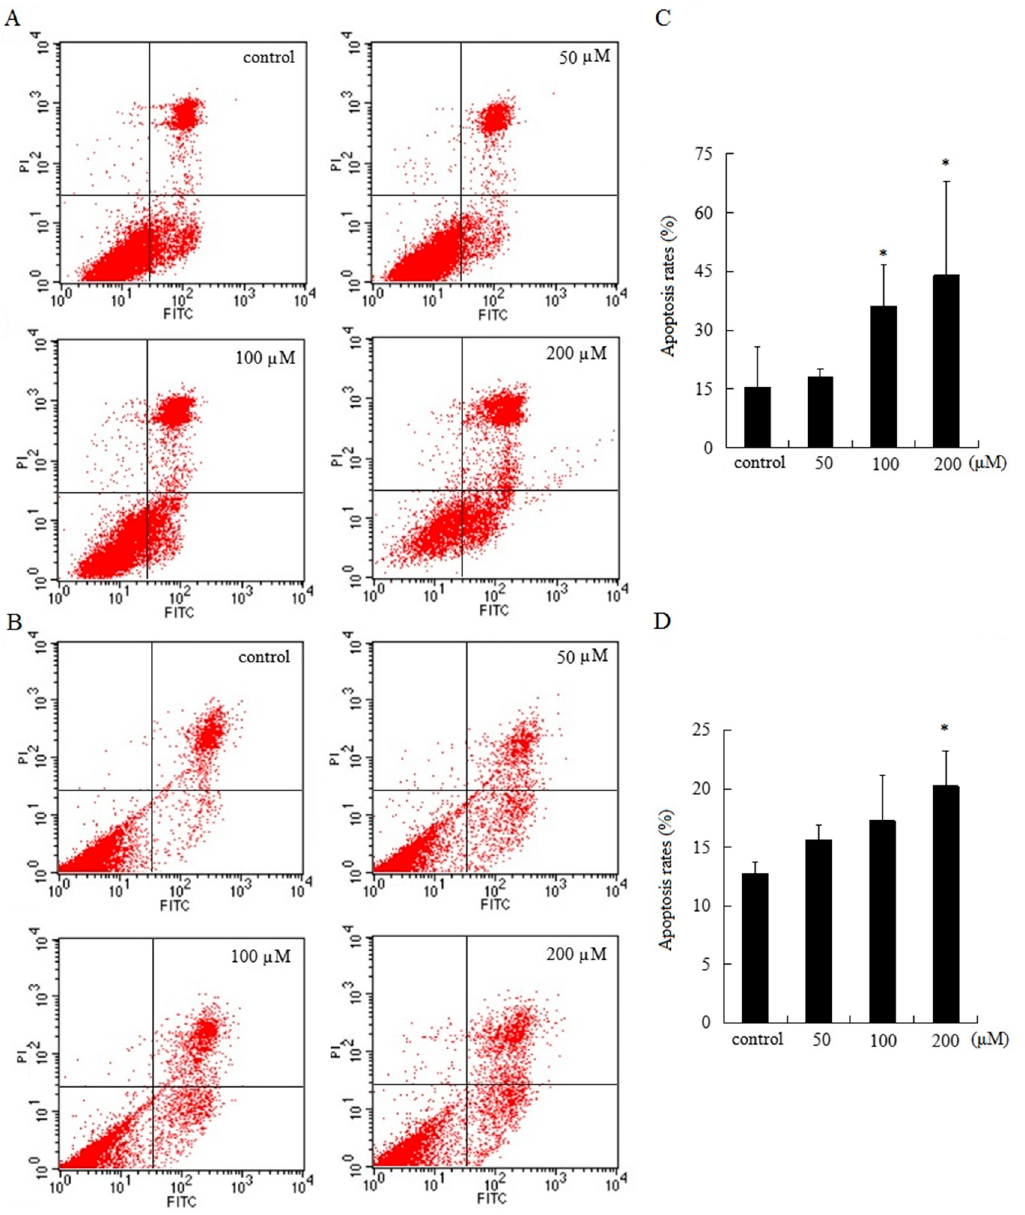
Figure 3. Apoptotic effects of AT-II on HGC-27 and AGS cells for 48 h. ( A ) HGC-27 cells; ( B ) AGS cells; ( C ) the percentages of apoptotic cells in HGC-27 cells; ( D ) the percentages of apoptotic cells in AGS cells. All experiments were performed in triplicates and expressed as mean ± SD. * p < 0.05 vs. control group.